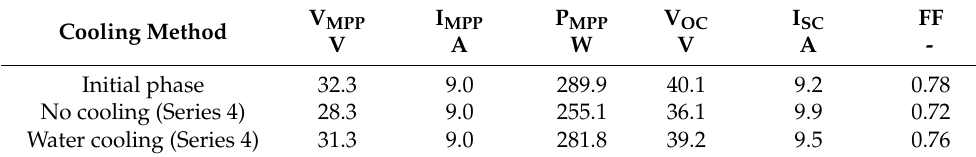
Table 2. Variations in the operating parameters of the tested 310 Wp PV